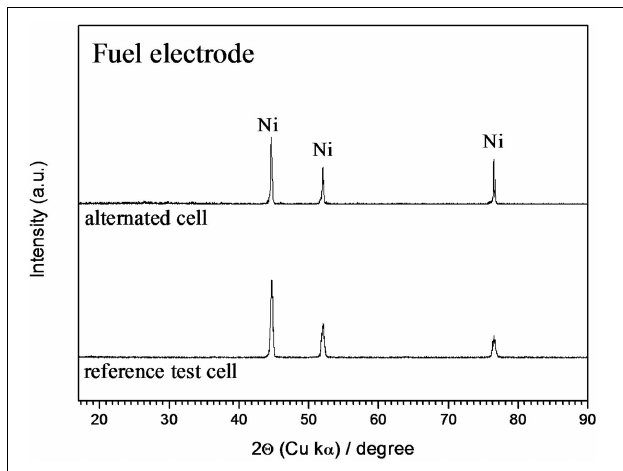
FIGURE 4 | XRD patterns of the spent Ni-Al alloy fuel electrode in reverse and reference test MCFC